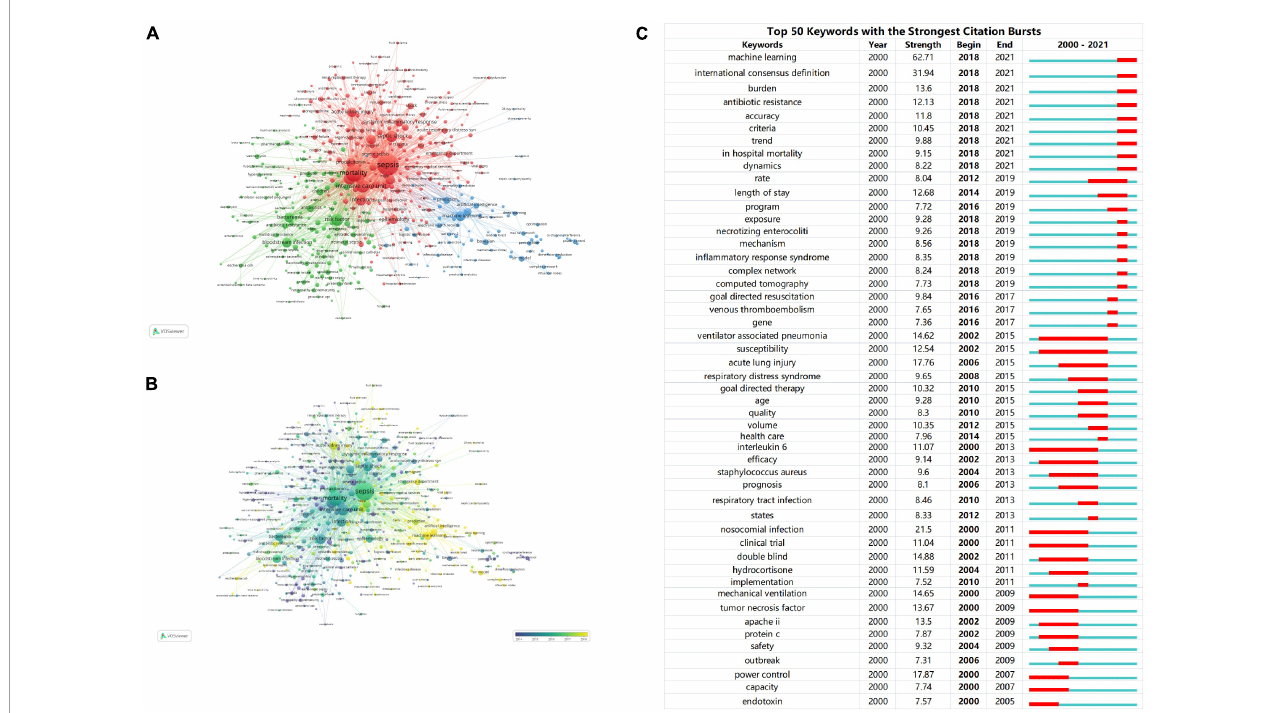
FIGURE9 (A) The network visualization map of keywords. The 469 keywords were divided into three clusters. Each cluster represents a different research topic. (B) The overlay visualization map of keywords. The color ranges from purple to green to yellow, indicating the years of keyword appearance from early to late. (C) Ranking of keywords with the strongest citation bursts related to artificial intelligence in sepsis. The strength values reflect the frequency of citation. Red bars indicate a burst period for the